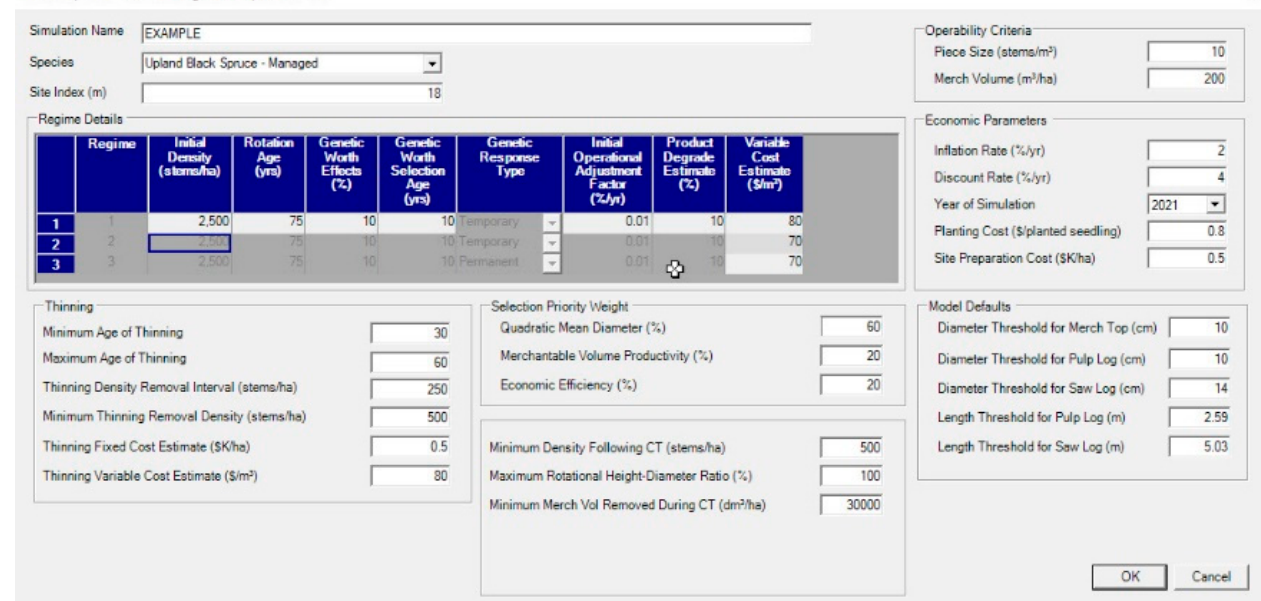
Figure A1. Exemplifying the automated crop plan selection capability of the CP DSS in regard to determining the optimal CT regime within upland black spruce plantations via the deployment of the Value Management Optimizer–CT. Specifically, the input GUI dialog inclusive of end-user required input consisting of the (1) simulation name, stand-type specification (species), site index, regime-specific specification of initial density, rotation age, genetic worth effect, selection age and response model, operational adjustment and product degrade factors, and variable cost estimate, and overall operability targets, economic assumptions and merchantable specifications applicable to all 3 regimes, (2) treatment specifics and constraints inclusive of the range of CT treatment ages (events), removal density searching interval (algorithmic requirement), minimum number of trees thinned (operational requirement), fixed and variable treatment costs, minimum post-thinning residual stand density, maximum height/diameter ratio tolerable and minimum recoverable merchantable volume required from the CT (operational requirement), and (3) multivariate selection priority weights (size, merchantable volume productivity and economic efficiency).